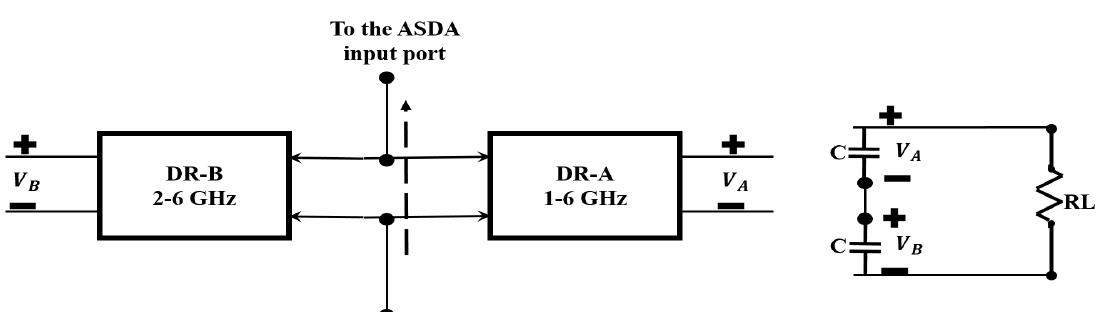
Figure 4. ( Left ) Block diagram of the two DRs adopted for the maximization of the rectifier operating frequency bandwidth. ( right ) Tiding of V A and V B for the connection of the terminal load.